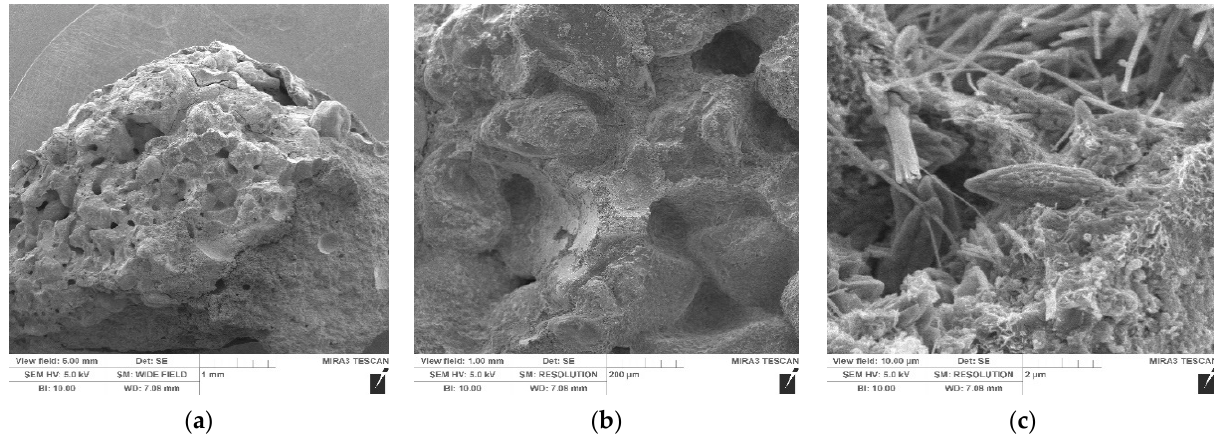
Figure 5. Microstructure of the cleavage surface of the 0.63 + 15% CB-2 specimen cube in the area of the isolated GA structure under various magnifications: ( a ) 5 mm; ( b ) 1000 μ m; ( c ) 10 μ m.